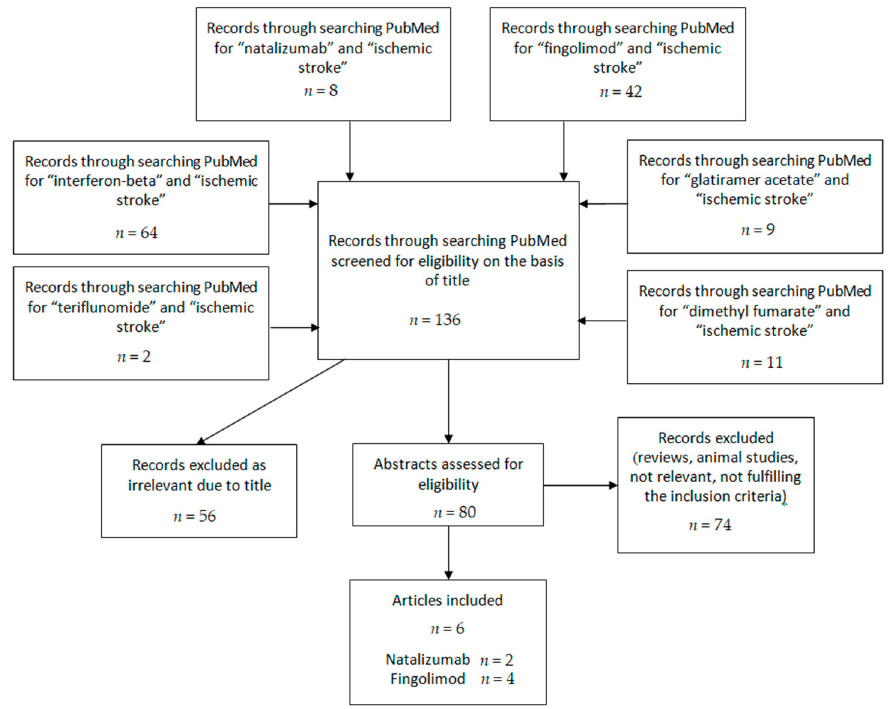
Figure 1. Flowchart for the search algorithm’s results.